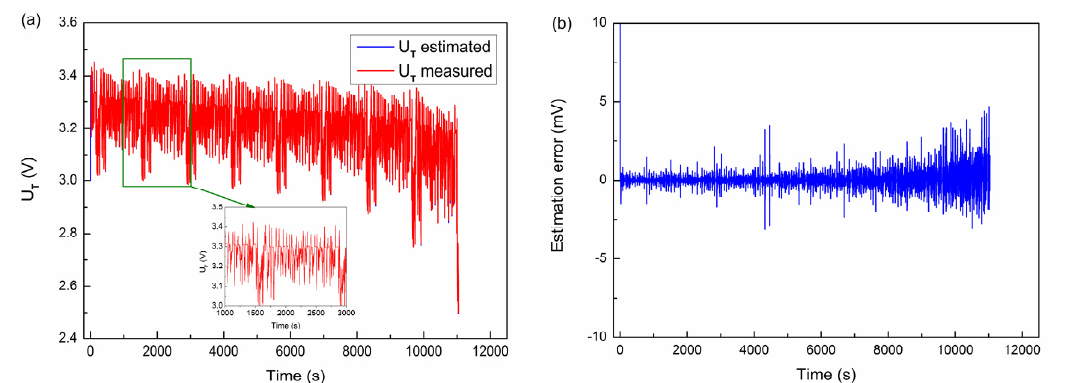
Figure 20. Validation of the identification method in the FUDS test at 10 °C: ( a ) the estimated voltage and measured voltage profiles and ( b ) the estimation error.